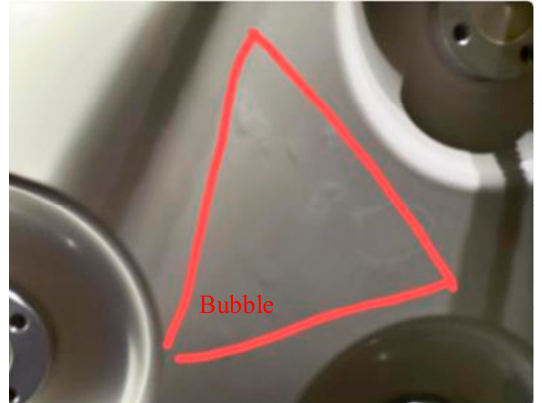
Figure 13. GIS partial discharge defect identification results. ( a ) channel 1, ( b ) channel 2, ( c ) chan- nel 3, ( d ) channel 4. 3, ( d ) channel 4.